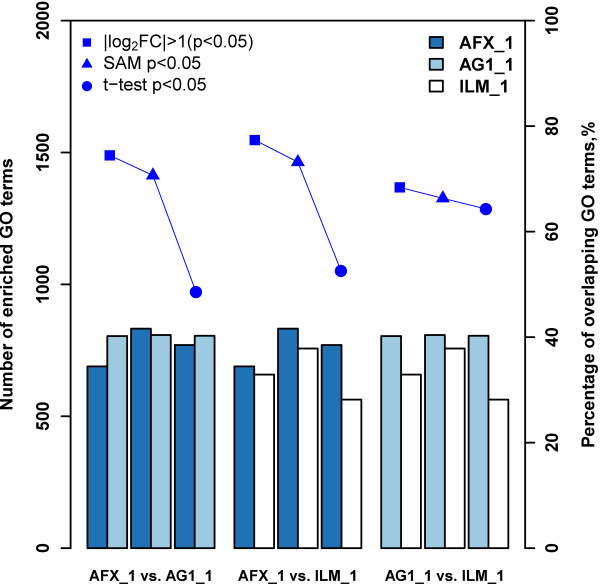
Inter-platform concordance of significant GO terms enriched by LRpath. The left y-axis represents the number of enriched GO terms by using LRpath for each of the platforms, and the right y-axis is the percentage (%) of overlapping GO terms. See notes under Figure 6 for more information. We can clearly see a drop of the percentages for DEG selection criteria t-test.